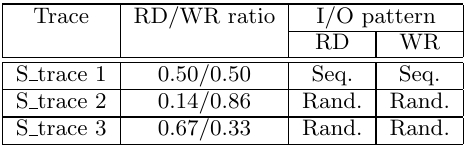
Table 2: I/O pattern and RD/WR ratio for Scien- tific workloads [15]